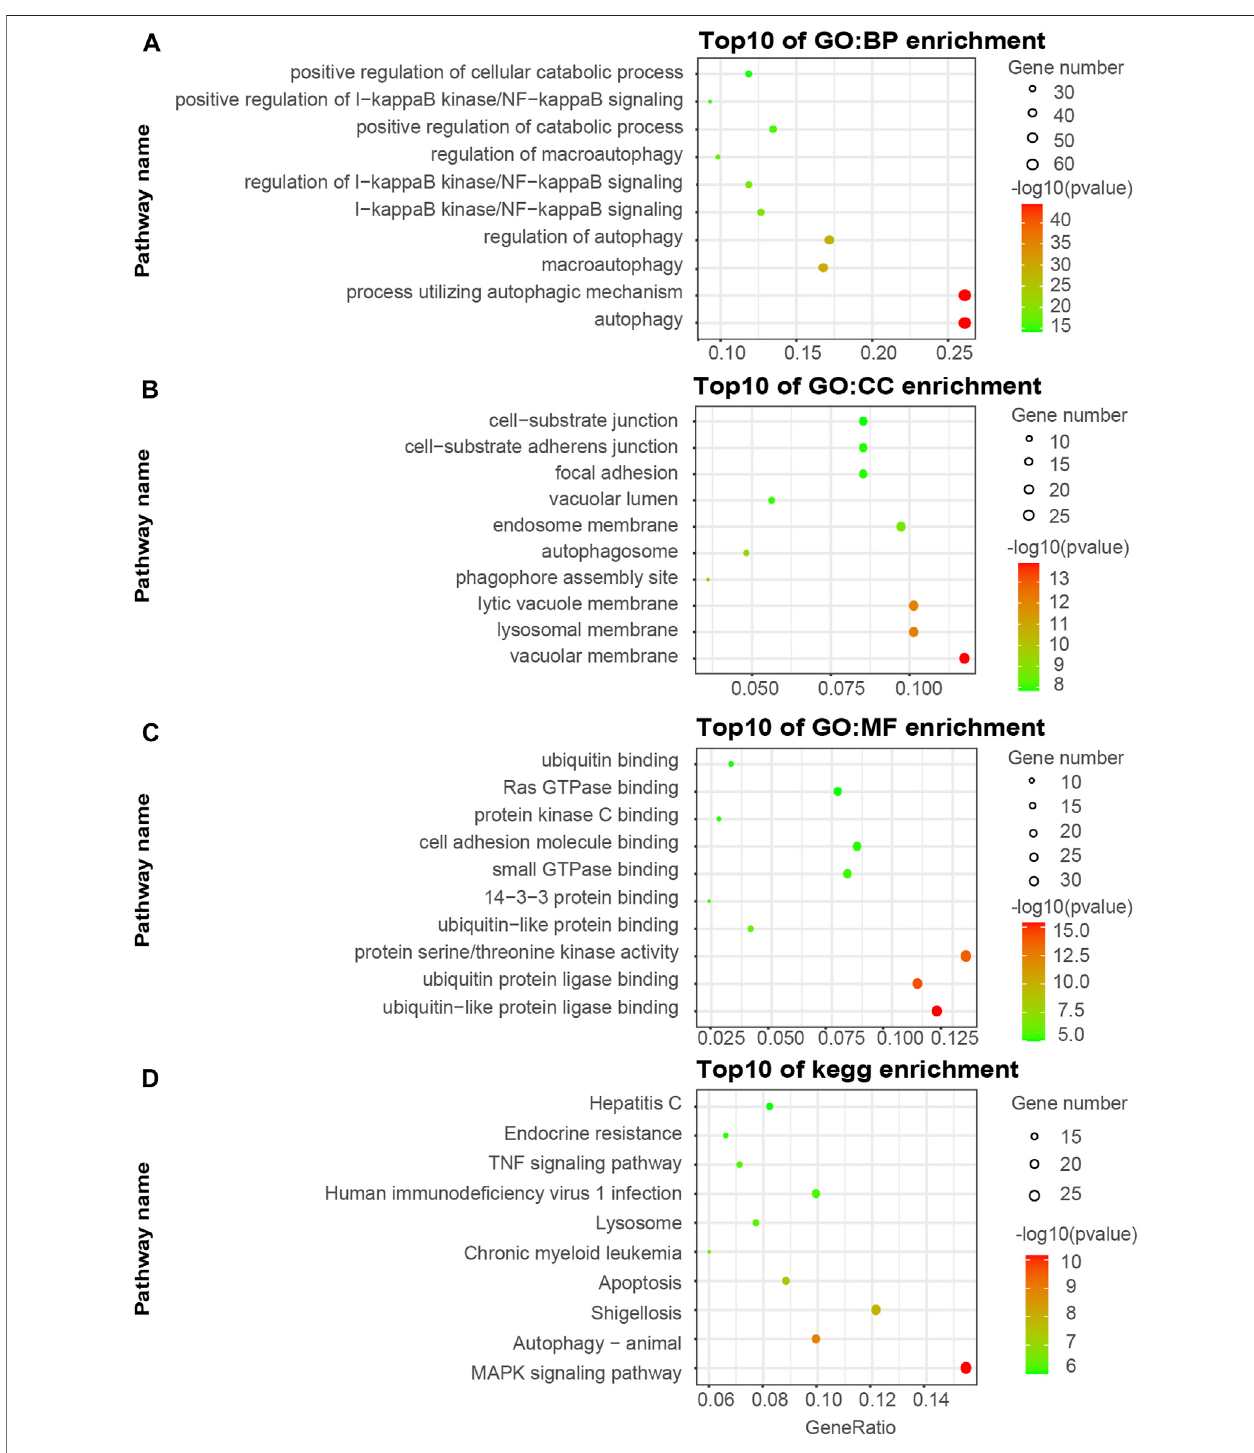
FIGURE 2 | Gene ontology (GO) and KEGG pathway enrichment analyses of ATGs in Brown (A – D) modules.